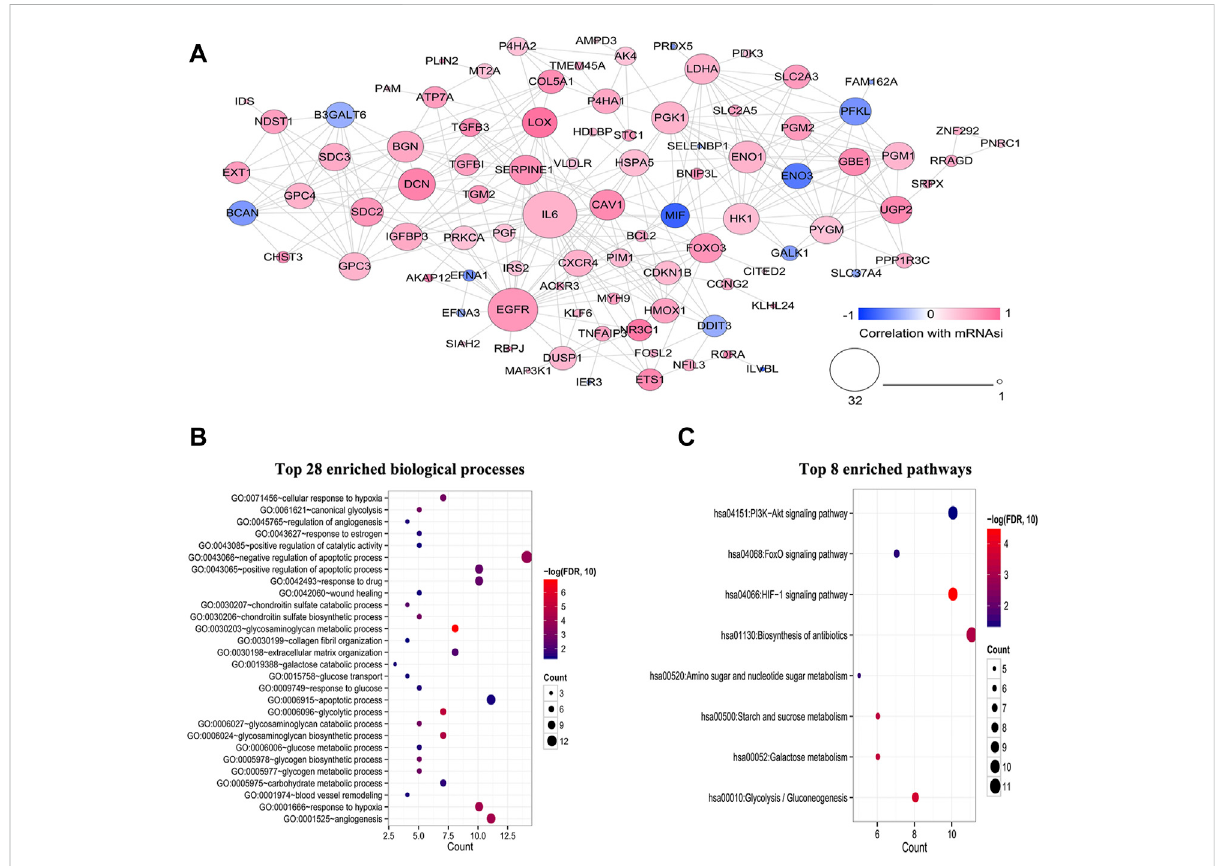
FIGURE 3 ConstructionofaPPInetworkandfunctionalenrichmentanalysisofHSRGs. (A)